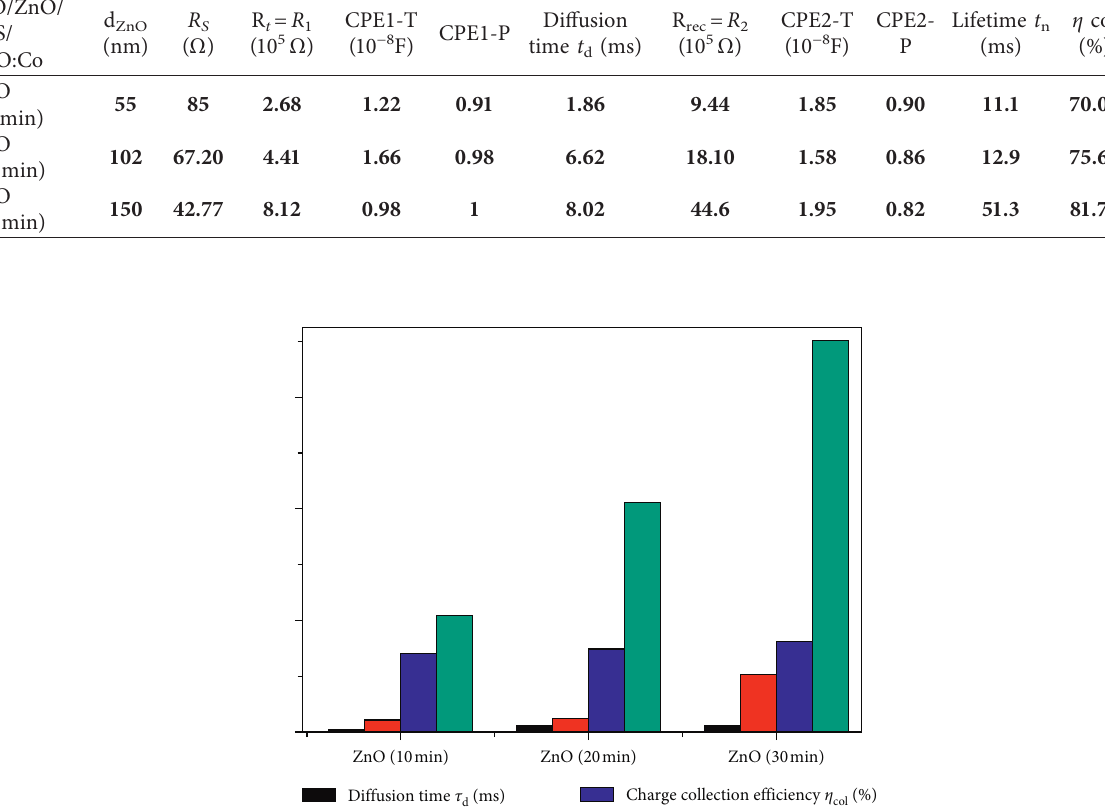
Table 3: Parameters from the fitting with the equivalent circuit for the ITO/ZnO/CdS/CuO:Co/Ag heterojunction solar cell. ITO/ZnO/